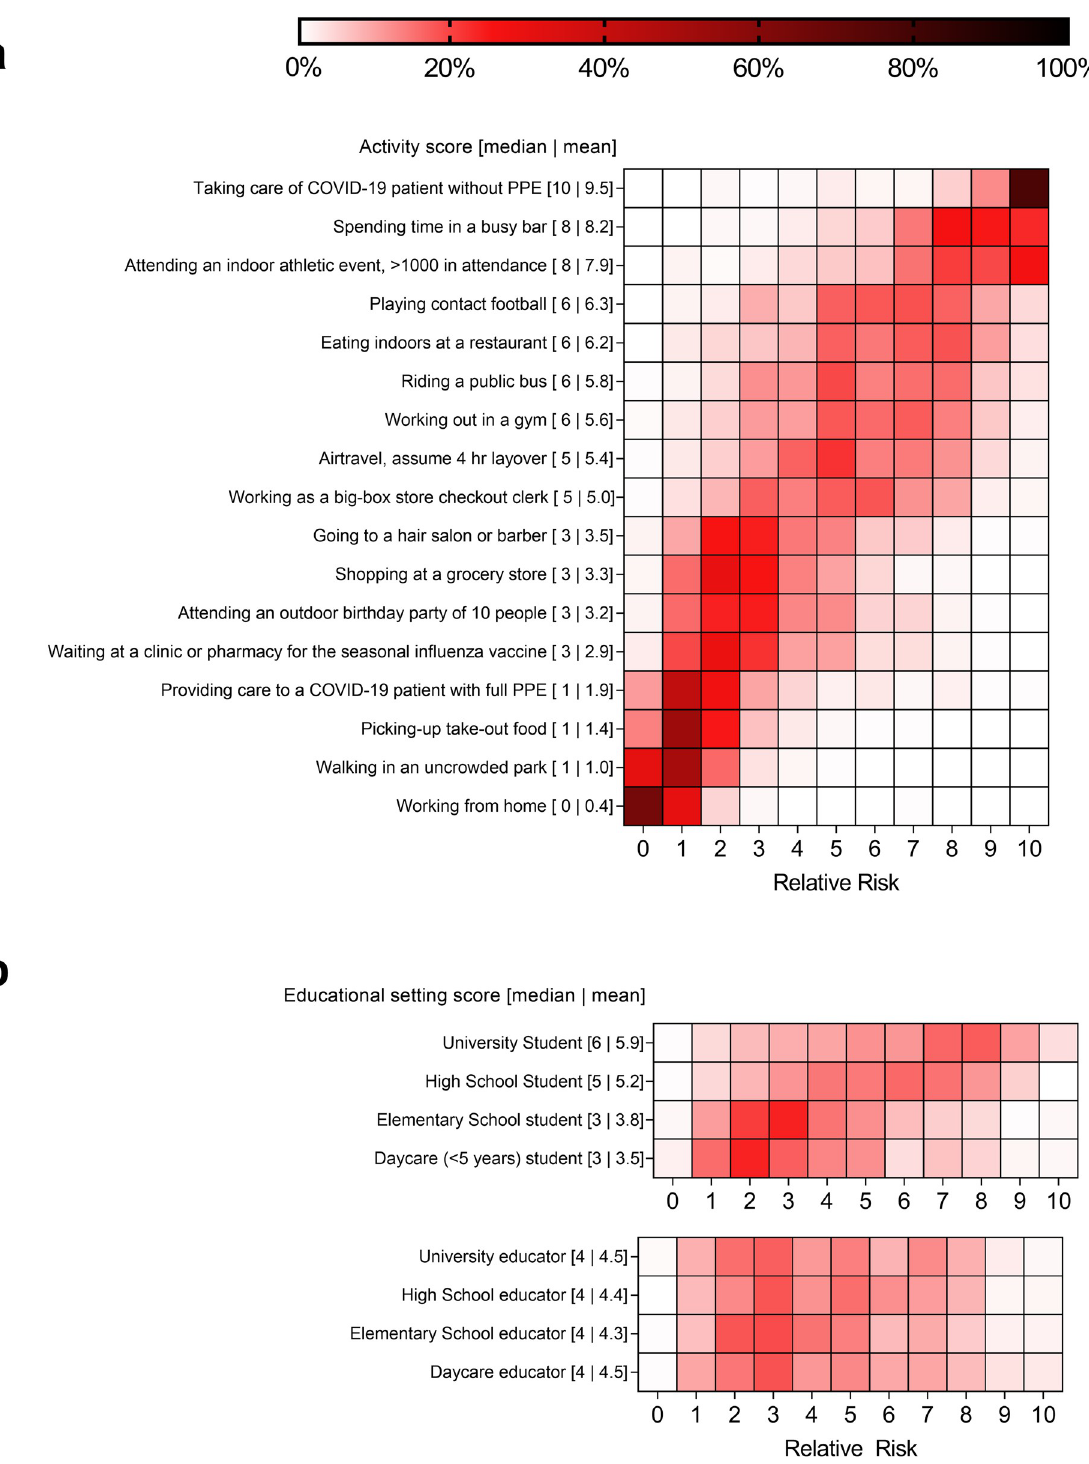
PLOS ONE | https://doi.org/10.1371/journal.pone.0263767 February 11,